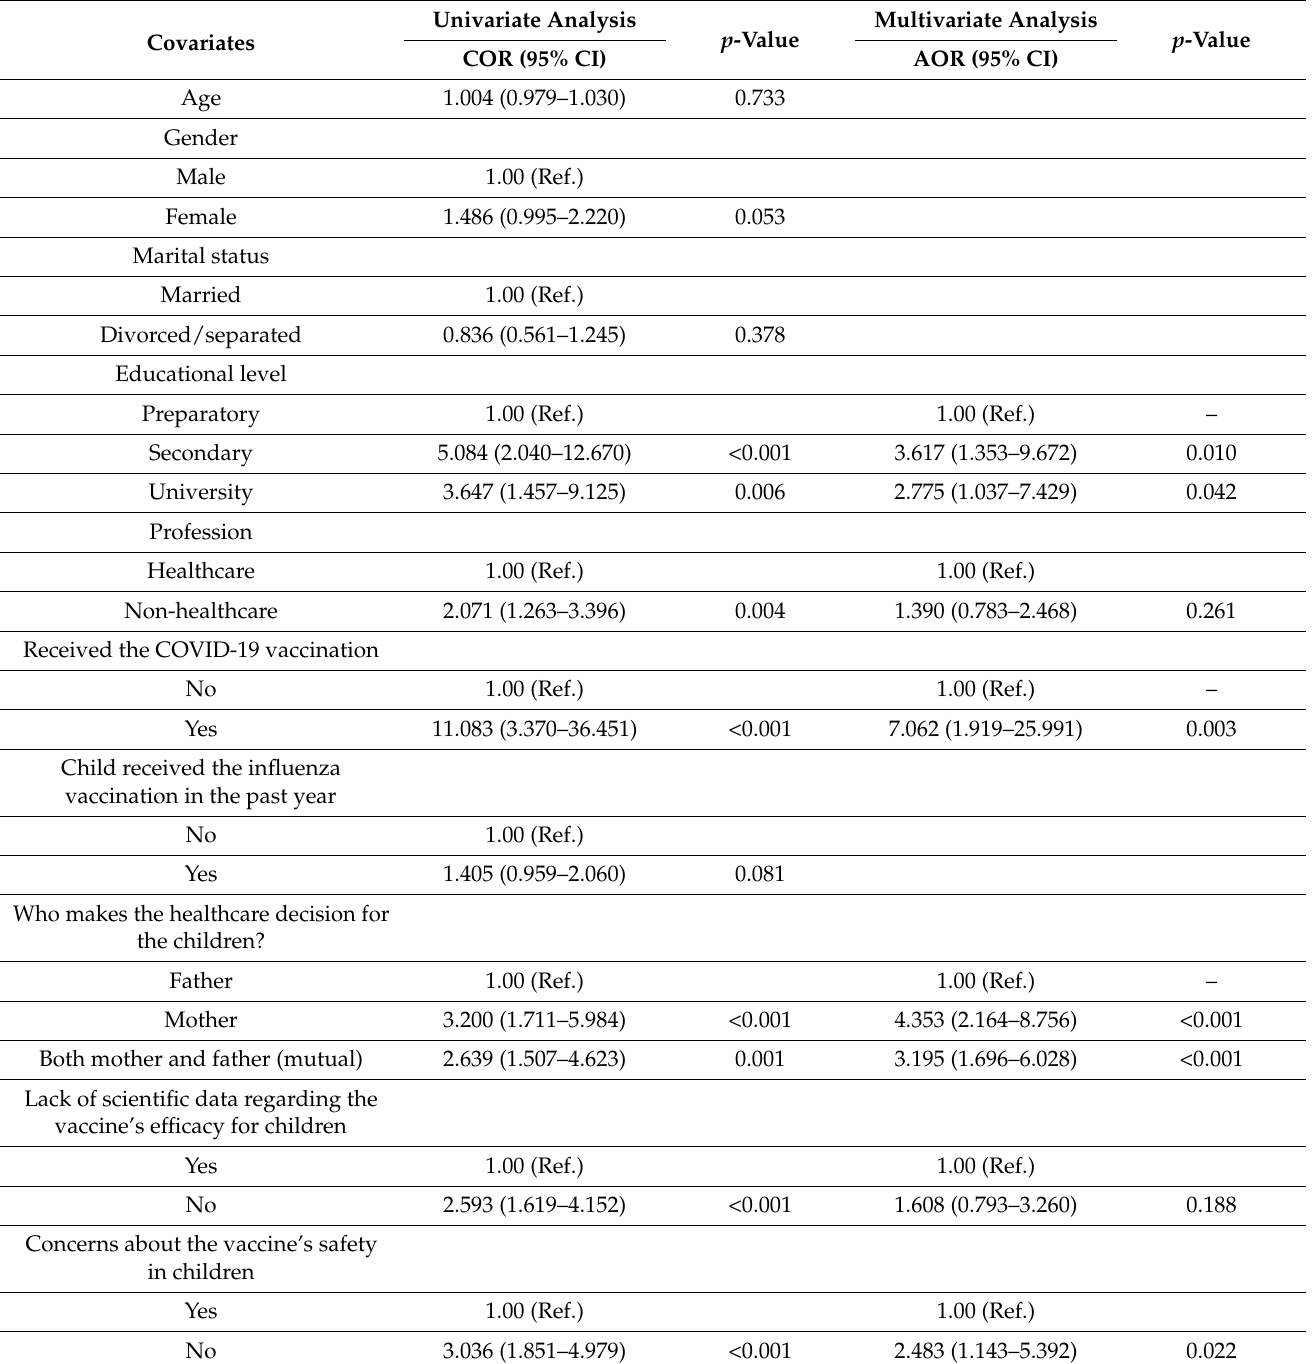
Table 4. Factors associated with Intention to Childhood COVID-19